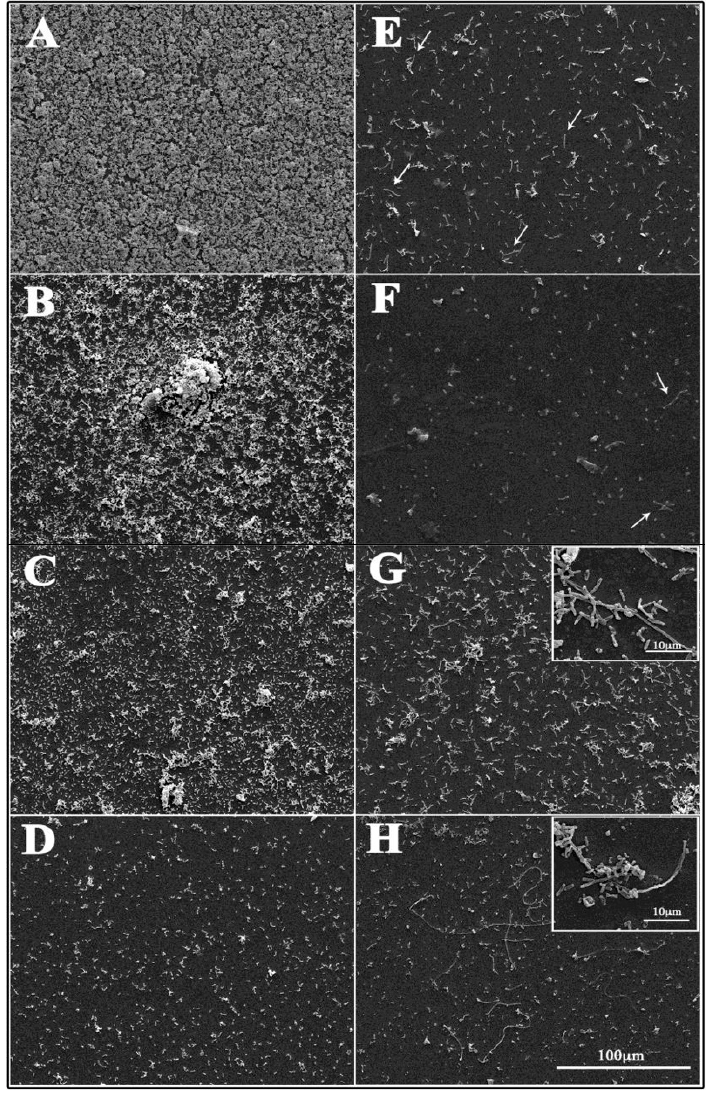
Figure 7. Scanning electron microscopy observations of avian E. coli strain biofilm formation after SEO NE treatment. Bacteria were allowed to develop biofilm on a glass slide for 48 h in the absence or presence of selected SEO NEs at sub-MIC concentrations. Micrographs show representative images of untreated (panels A – D ) or SEO NEs (panels E – H ) treated bacterial cells. Arrows and insets indicate elongated bacteria induced by NE treatment. Biofilm formation of LF82 (control strong biofilm producer) ( A , E ), AV2 (strong biofilm producer) ( B , F ), AV6 (moderate biofilm producer) ( C , G ), and AV11 (weak biofilm producer) ( D , H ) strains.